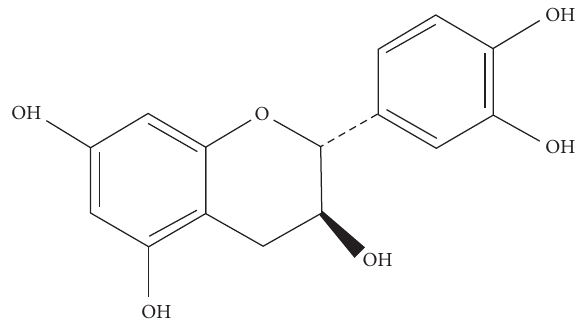
Figure 1: Molecular structure of